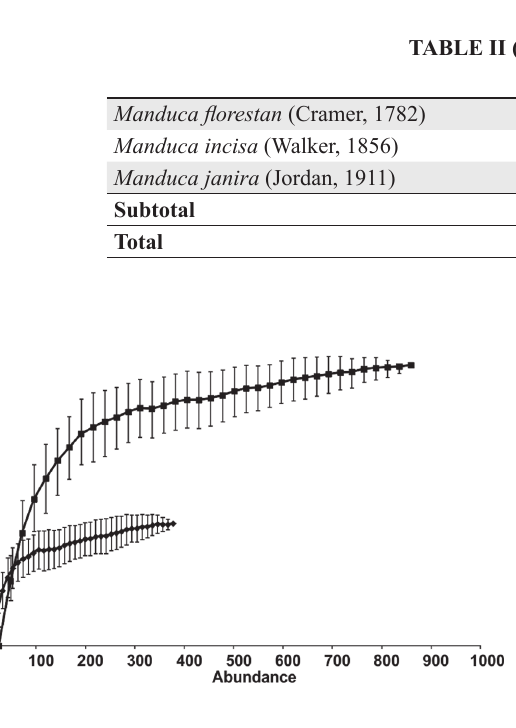
Figure 2 - Curve of estimated richness (Jacknife 2) and their deviations for Saturniidae (points) and Sphingidae (triangles) for 12 samples between November 2010 and September 2011.